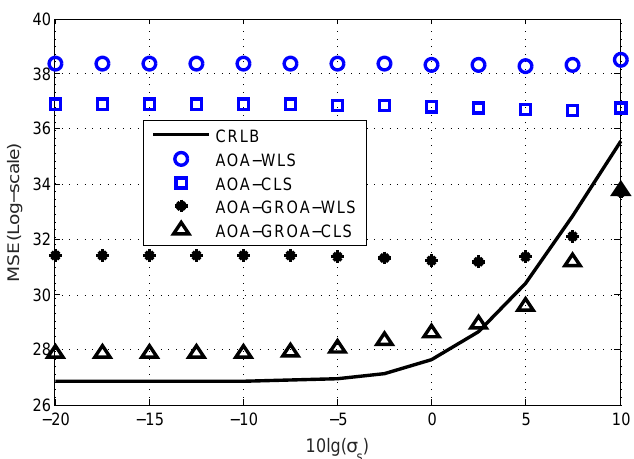
Figure 5. Average MSE results of AOA-only WLS, AOA-only CLS, AOA-GROA WLS and AOA-GROA CLS methods, σ s varies, whereas σ AOA = 10 − 2 radian and σ GROA = 3 × 10 − 3 .